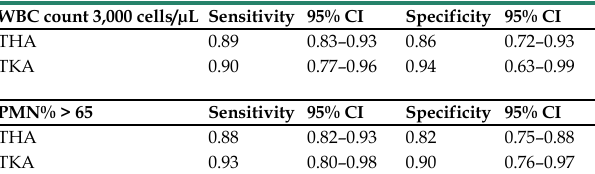
Table 1. Synovial fluid analysis in THA vs TKA according to the meta-analysis of De Fine et al .